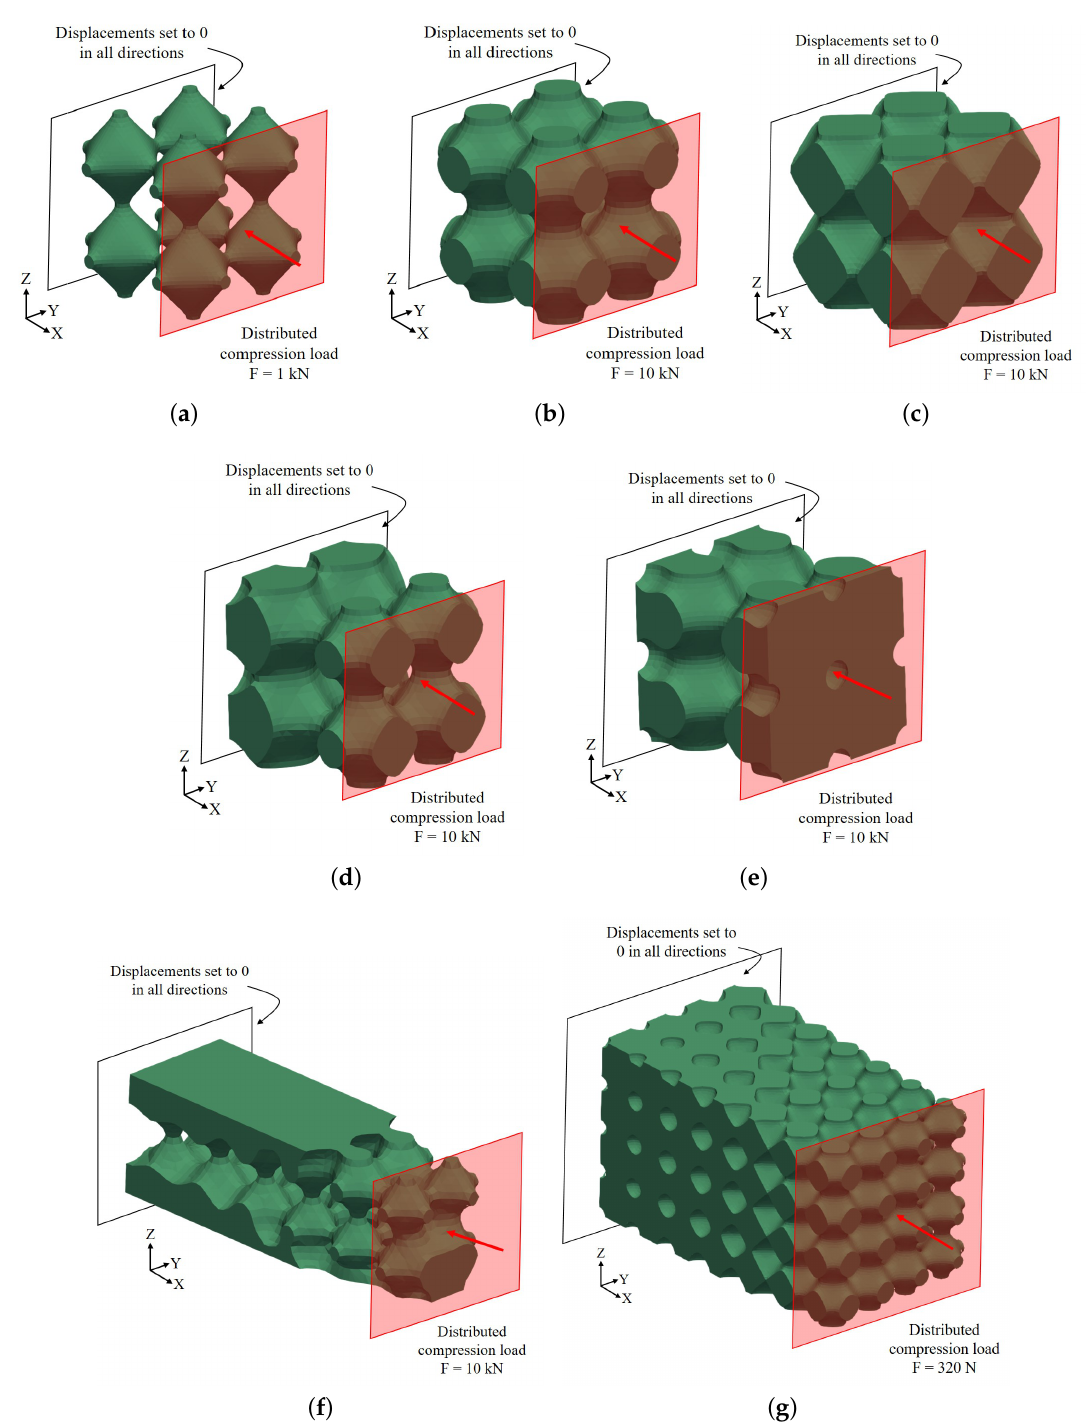
Figure 5. Studied domains and boundary conditions for the FEA simulations. Domains of eight cells of uniform density ( a ) ρ = 0.25; ( b ) ρ = 0.50; and ( c ) ρ = 0.75. Domains of eight cells of density ( d ) per Equation (9); and ( e ) per Equation (10). ( f ) Domain of 24 cells with density per [7]. ( g ) Domain of 112 cells with density per Equation